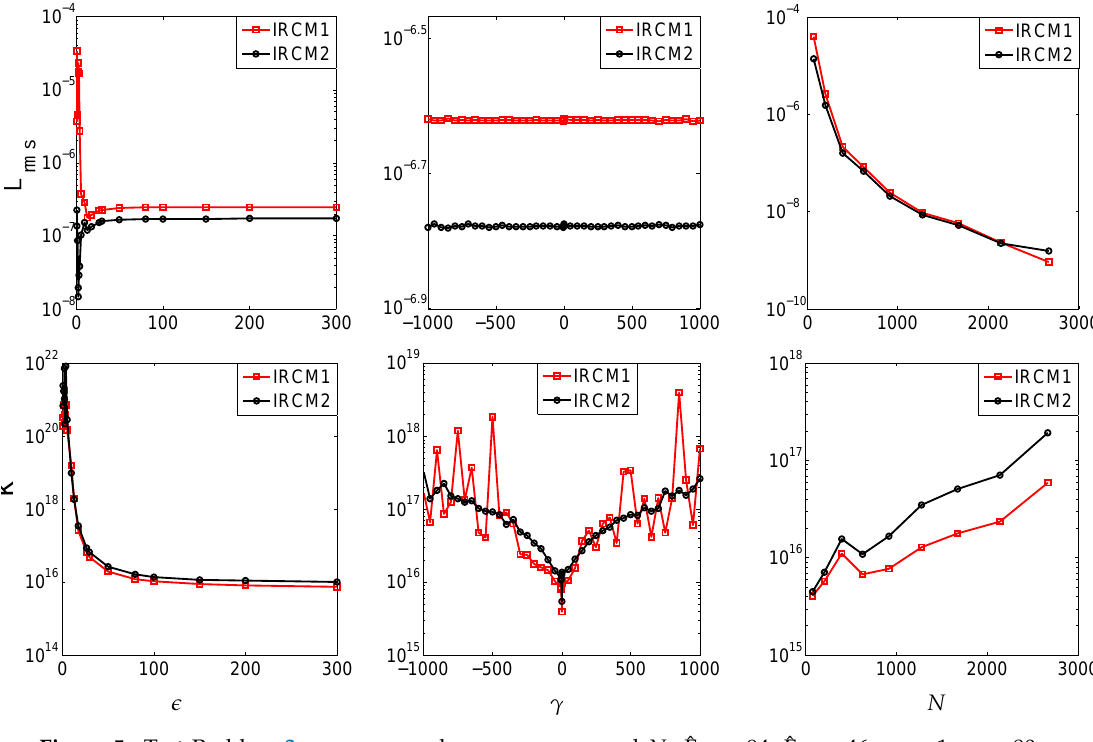
Figure 5. Test Problem 2, accuracy and κ versus (cid:101) , γ , and N : ˆ Γ 1 = 94, ˆ Γ 2 = 46, γ = 1, (cid:101) = 80, and N = 320 when its influence is interestless.